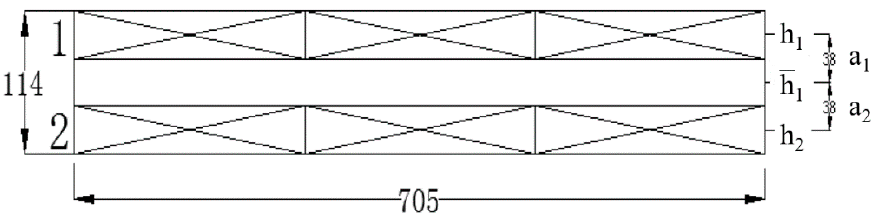
Figure 14. Illustration of 3 ‐ layers CLT panels.